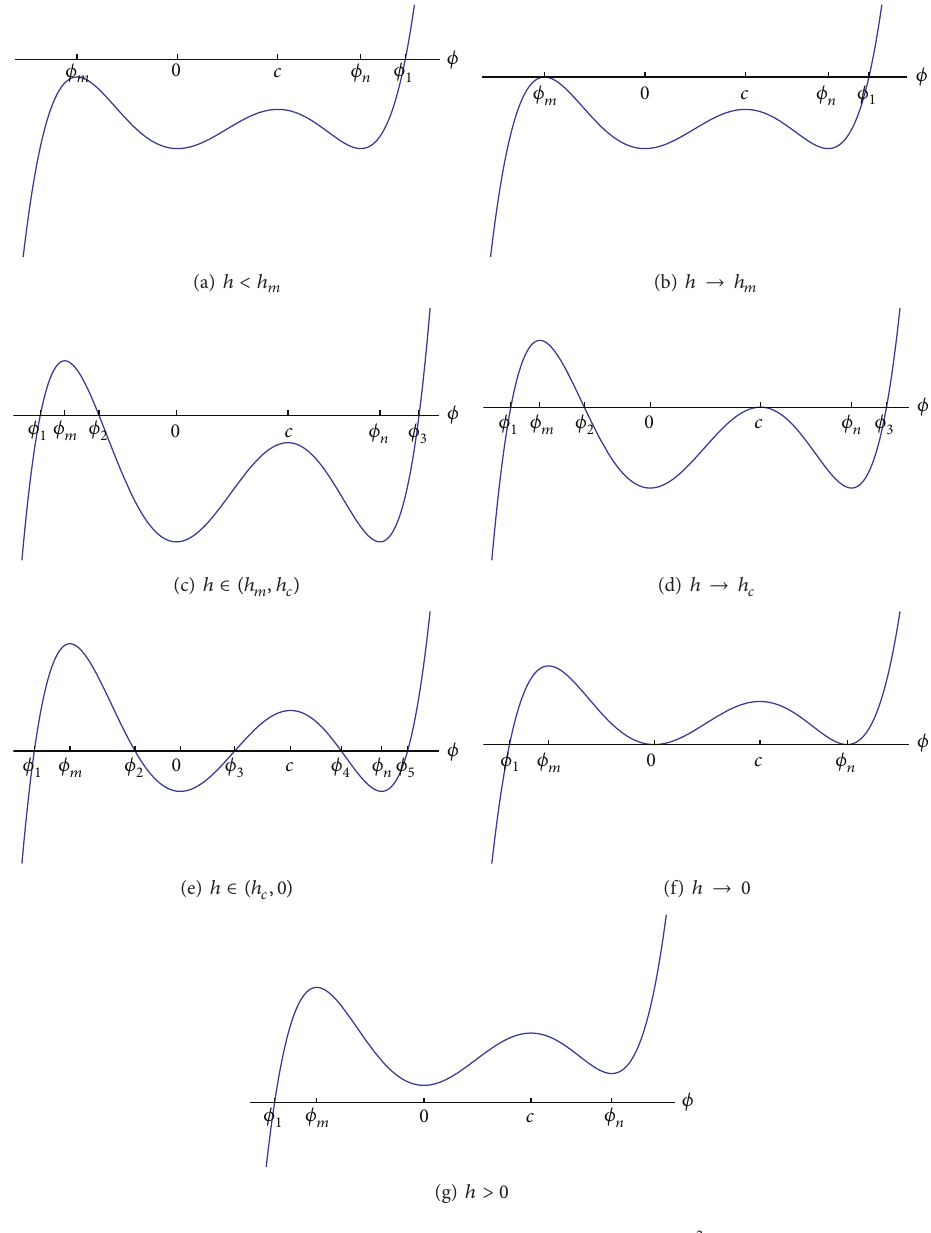
Figure 3: The graph of 𝐹(𝜙) as 𝑐 0 = (1/16)(16𝑐 − 75𝑐 2 )